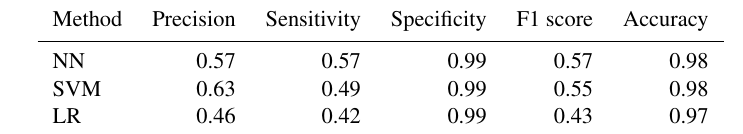
Table 7. Comparison metrics best configuration for flood by method.